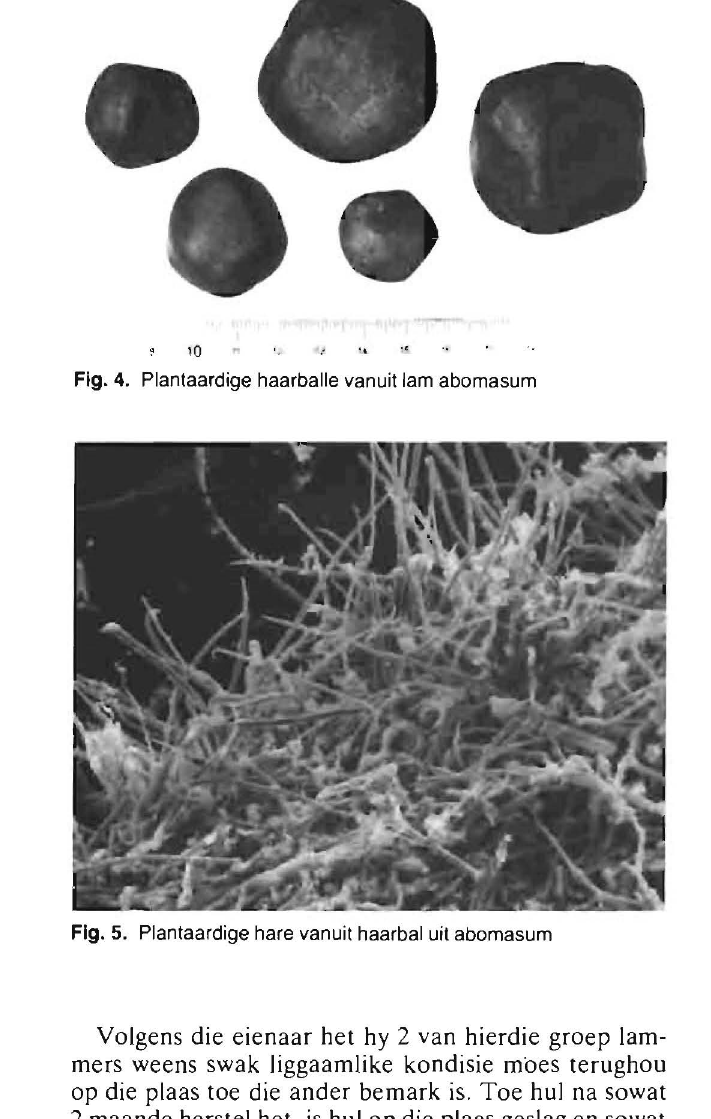
Volgens die eienaar het hy 2 van hierdie groep lam mers weens swak Jiggaamlike kondisie moes terughou op die plaas toe die ander bemark is. Toe hul na sowat 2 maande herstel het, is hul op die plaas geslag en sowat 15 balle per skaap in onveranderc;le toestand in die abomasum